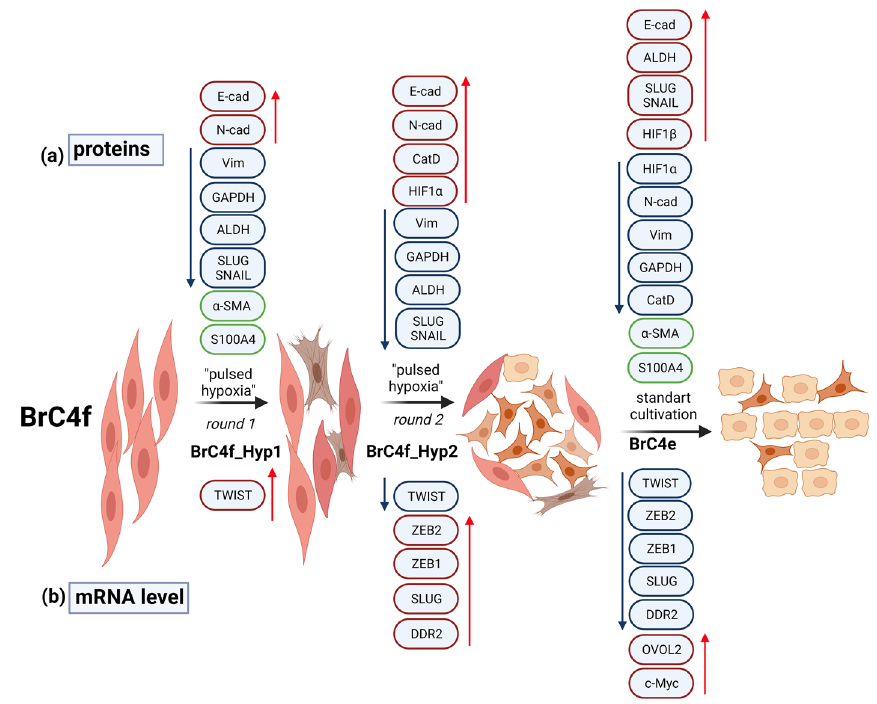
Figure 8. Resulting scheme of undergoing MET at different stages of breast CAFs by “pulsed hypoxia”. Changes in MET markers of ( a ) proteins and ( b ) genes. Red arrows indicate the increase, and blue arrows indicate the decrease, in markers compared to BrC4f cells (control). Green boxes indicate stable state of